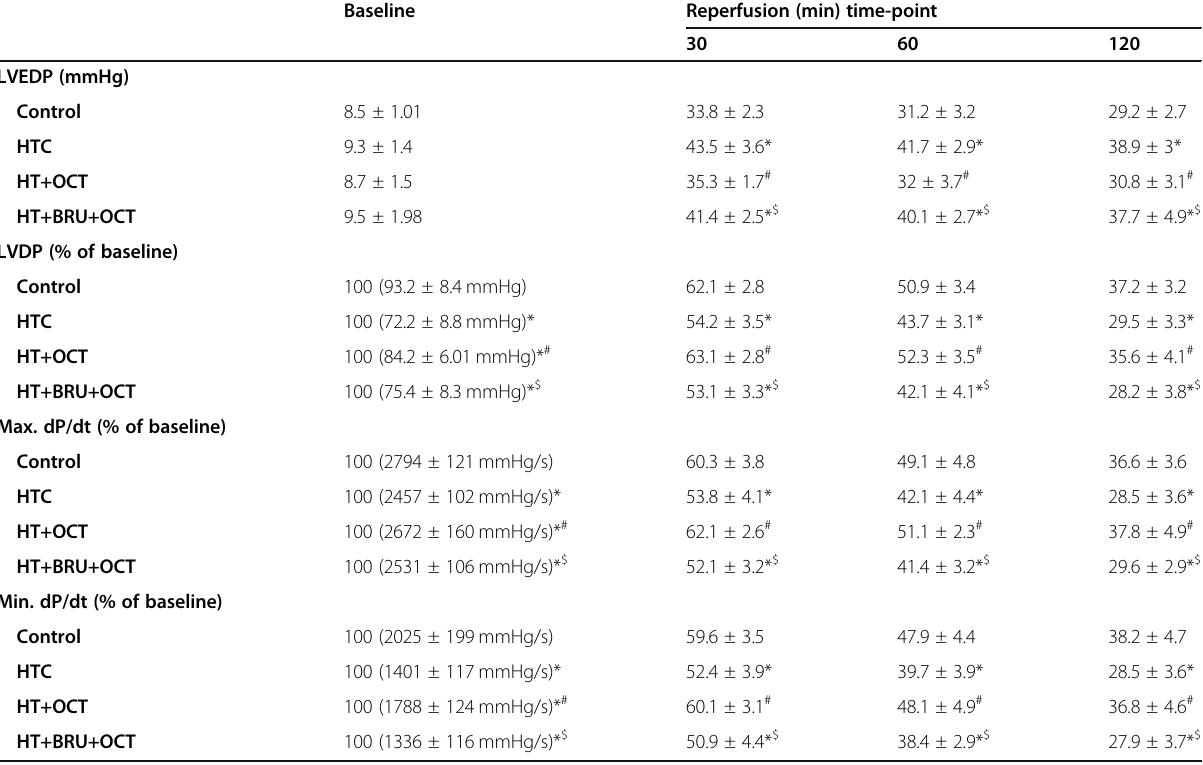
Table 2 Effect of octreotide on left ventricular hemodynamic parameters in hyperthyroid rat hearts exposed to